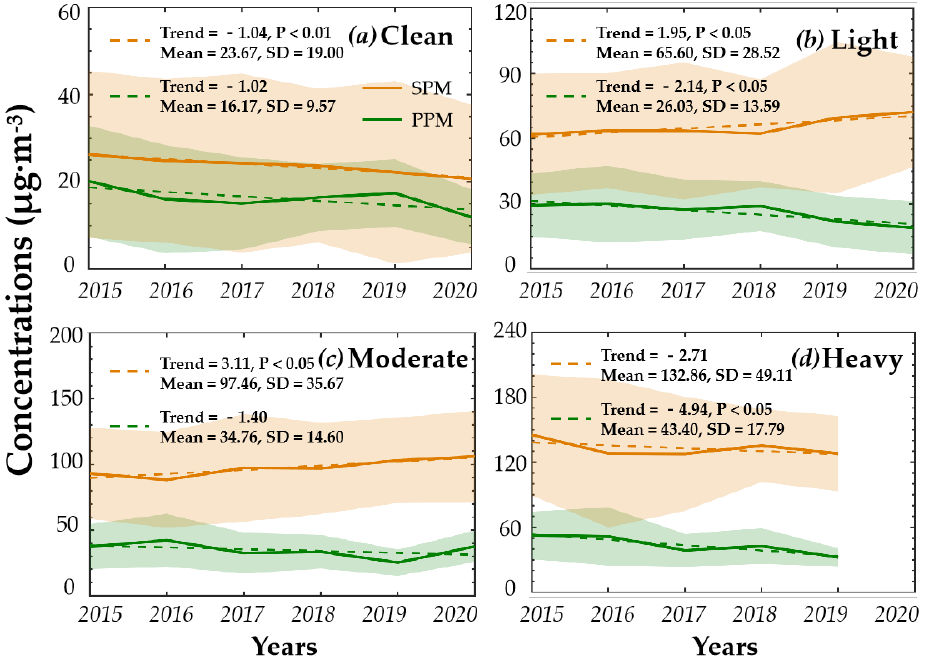
Figure 4. Interannual variations in PPM and SPM (solid lines) with linear fitting lines (dashed lines) in clean (air quality), light, moderate, and heavy (PM 2.5 pollution) levels from 2015 to 2020. PPM and SPM are respectively shown in green and red lines. The values inset in each panel is the Trend (linear fitting trends) with p -value less than 0.05. Mean denotes the concentrations of PPM and SPM averaged over 2015–2020. SD represents the 6-year average of annual standard deviations, which are calculated based on daily variations in SPM and PPM for each year. Shaded areas represent ± 1 standard deviations. ( a ) Clean; ( b ) Light; ( c ) Moderate; ( d )